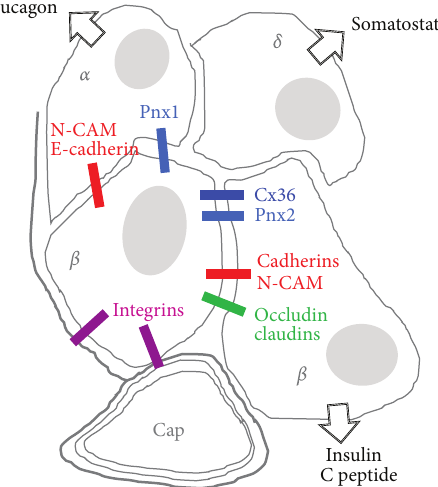
F 3: Schematic view of the pancreatic islet. e insulin- and C-peptide-producing